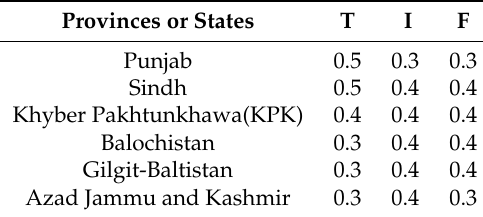
Table 1. IN set O of provinces of Pakistan.